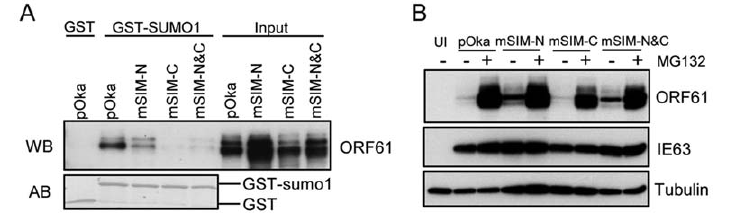
Figure 4. ORF61 SIMs are essential for the SUMO-binding capacity of ORF61 expressed in VZV-infected cells. (A) Binding of ORF61 SIM mutant proteins produced from infected cells to SUMO1 in GST pull down. Western blot with ORF61 antibody shows the ORF61 and SIM mutant proteins bound to SUMO1/2; amido black (AB) staining shows GST and GST-SUMO1/2 levels. (B) The processing of ORF61 and SIM mutant proteins in infected cells. Melanoma cells infected with pOka and ORF61 SIM mutant viruses were mock-treated or treated with MG132. Western blots of ORF61, IE63 (a VZV immediate early protein), and tubulin are shown. IE63 serves as the control for VZV infection. UI indicates uninfected cells.